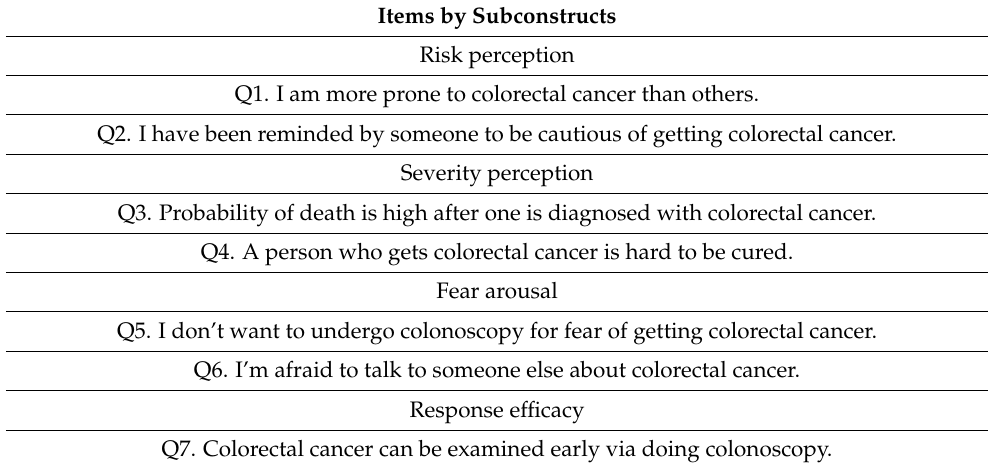
Table A2. Items of the 16-item colorectal cancer PMT